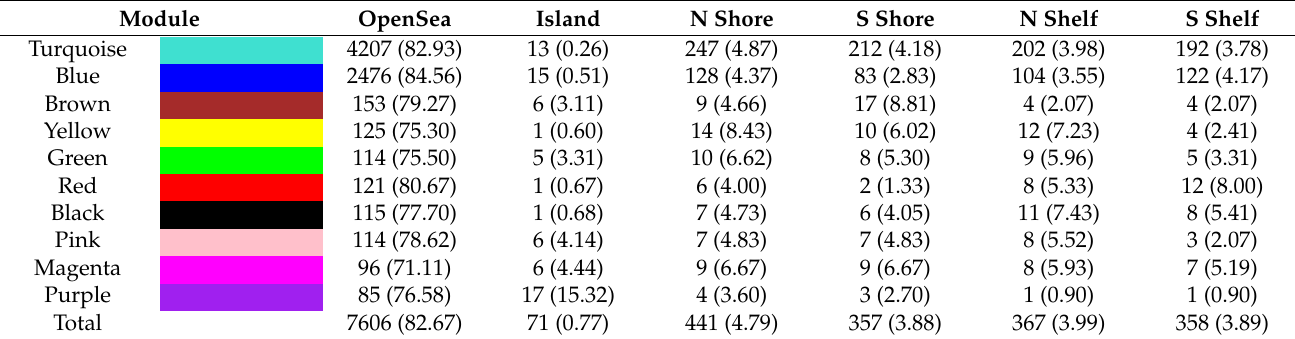
Table 3. CpG site position with respect to CpG